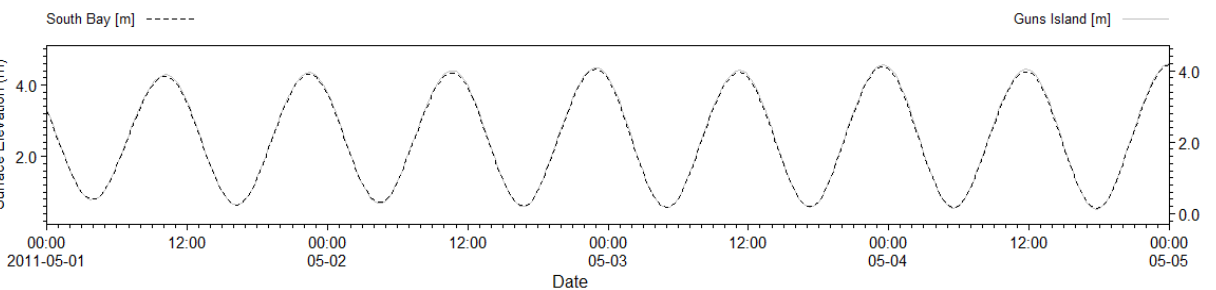
Figure 5. Comparison of South Bay and Guns Island surface elevation data obtained in May